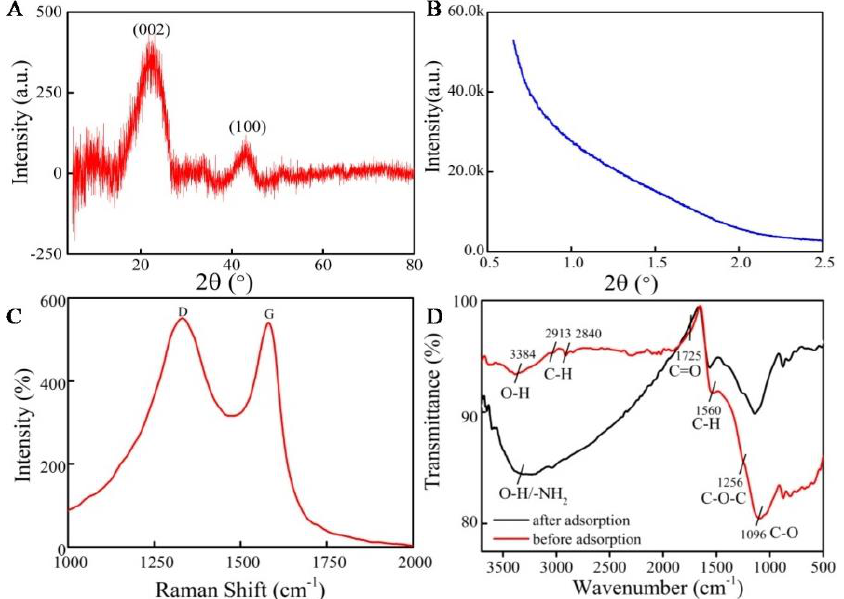
Figure 2. Characterization of MCNs by ( A ) XRD patterns, ( B ) SAXS patterns, ( C ) Raman spectra, and ( D ) FTIR spectra.